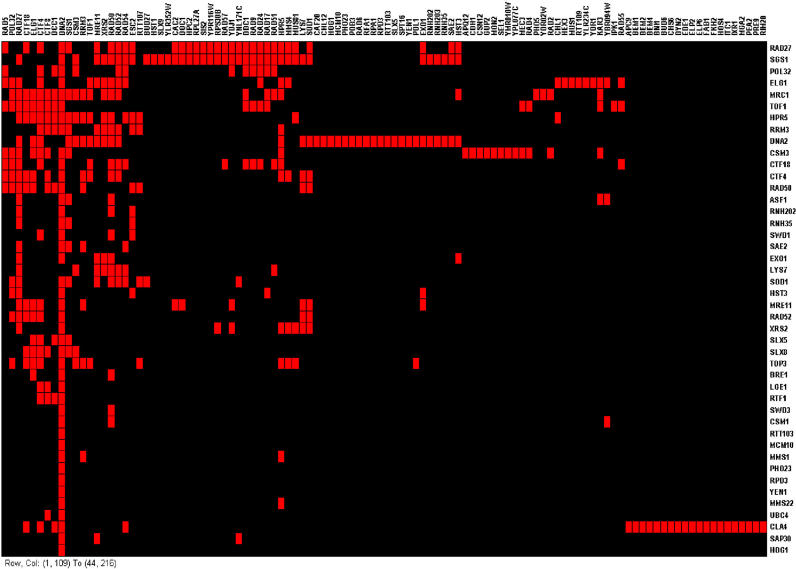
Clustering AnalysisHierarchical two-dimensional clustering analysis was applied to the DNA2 interactions and those of 43 genes synthetically lethal with DNA2 (see Table 1). The interactions were clustered with respect to the results of the current screen and 43 previous screens using these genes as queries. A total of 322 genes and 876 interactions, each indicated by a red box, were identified. This panel shows a zoom into the region of most significant overlap of shared genetic interactions. In addition to including reduced fitness genes, this analysis includes genes that give increased fitness with dna2, such as pol32Δ.